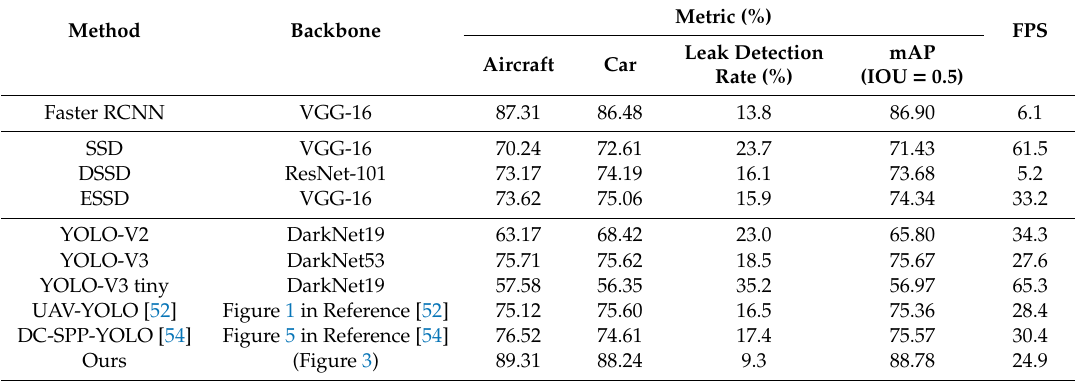
Table 9. Experimental comparisons of accuracy and speed in the UCS-AOD